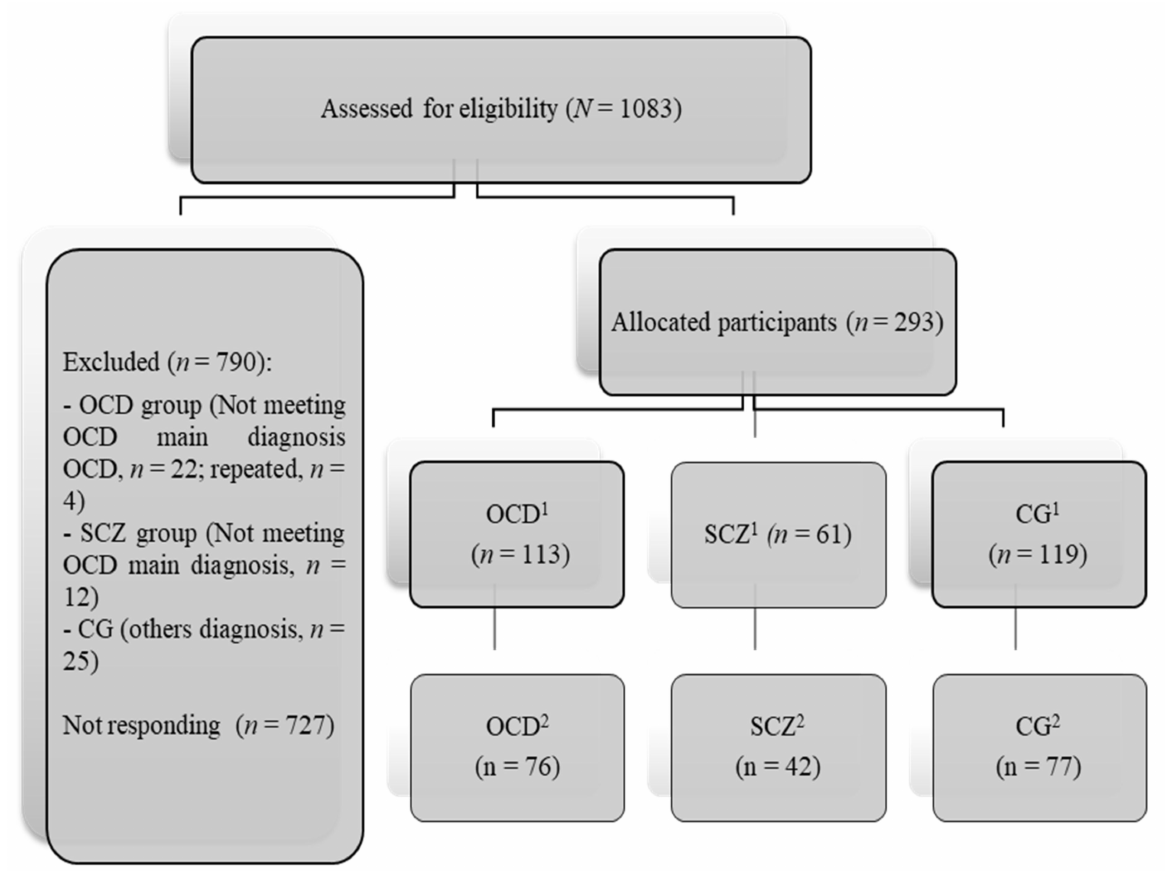
Figure 1. CONSORT Flow diagrams of study development. Note: OCD: obsessive–compulsive disorder, SCZ: schizophrenia; CGC: control group. 1 April; 2